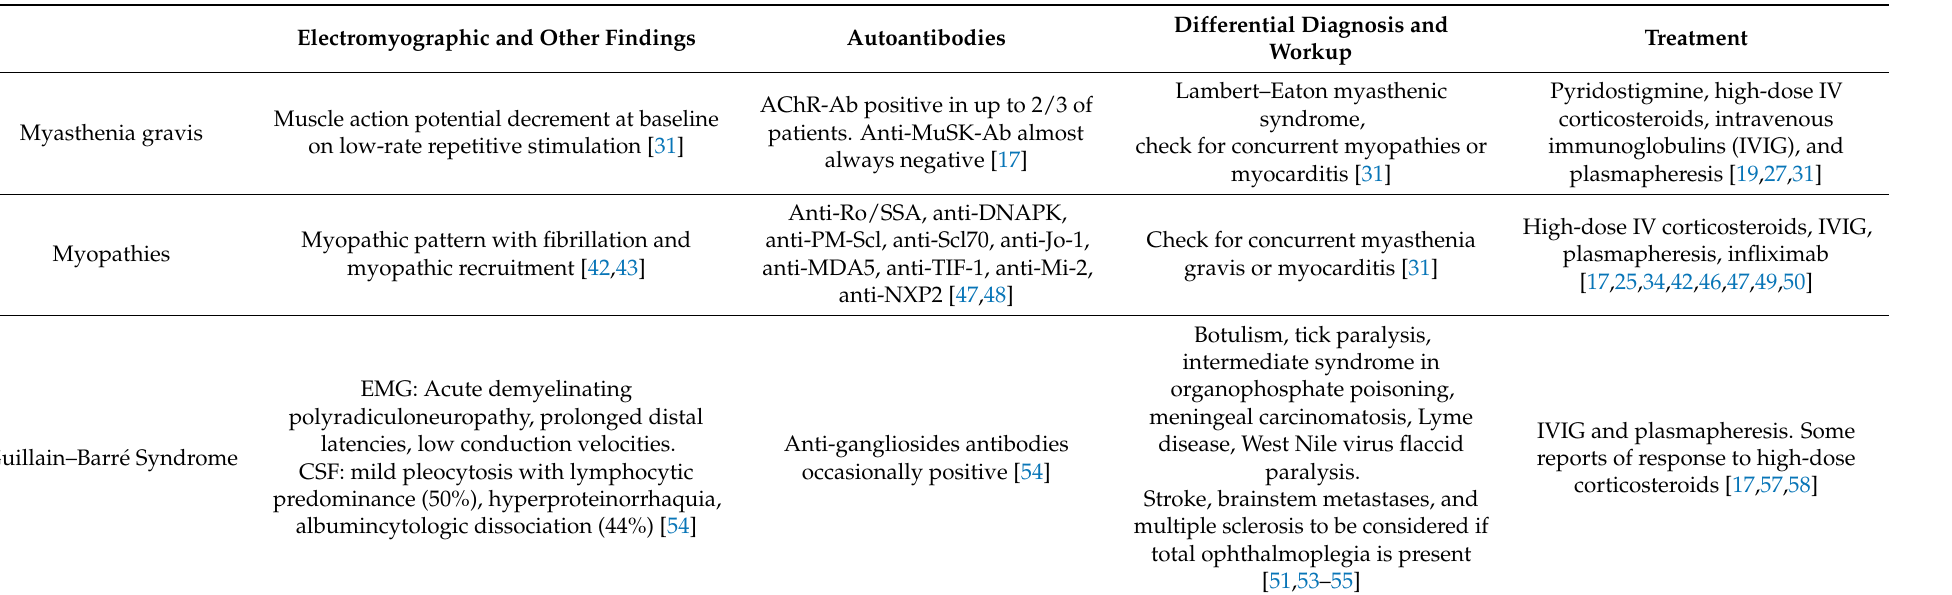
Table 2. Summary of diagnostic workup of neuromuscular